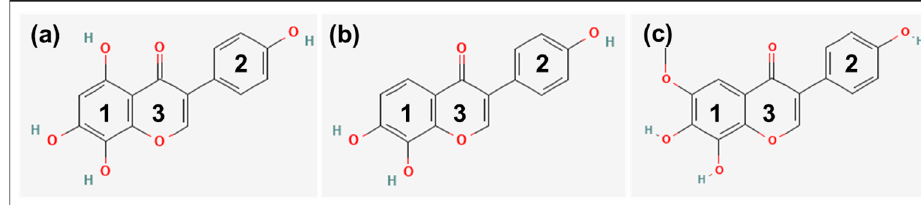
Figure 1. Chemical structure of ( a ) 8-hydroxygenistein (8OHGen; 4 ′ ,5,7,8-Tetrahydroxyisoflavone; C 15 H 10 O 6 , PubChem CID: 5492944), ( b ) 8-hydroxydaidzein (8OHDai; 7,8,4 ′ -Trihydroxyisoflavone; C 15 H 10 O 5 , PubChem CID: 5466139) and ( c ) 8-hydroxyglycitein (8OHGly; 7,8,4 ′ -Trihydroxy-6-meth-